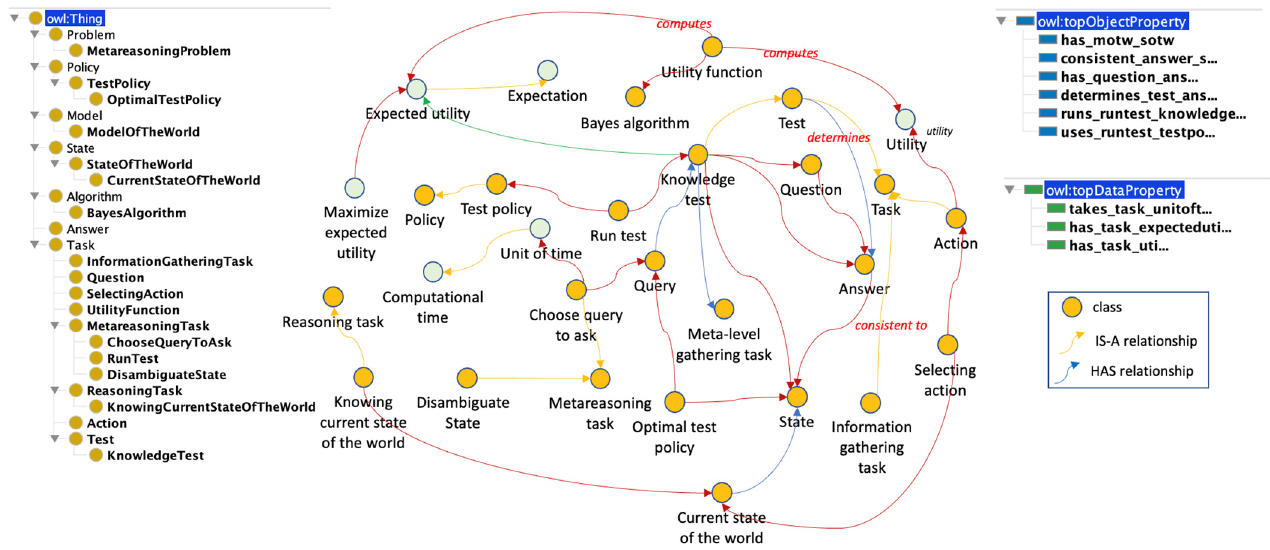
Figure 8. The KTP subontology.